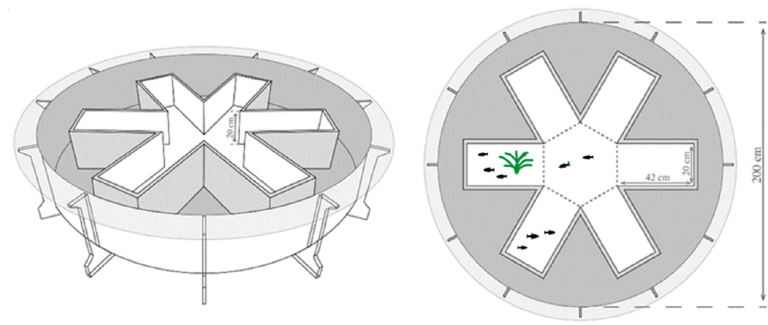
Figure 1. Schematic drawing of the radial six ‐ arm maze used in the present study.